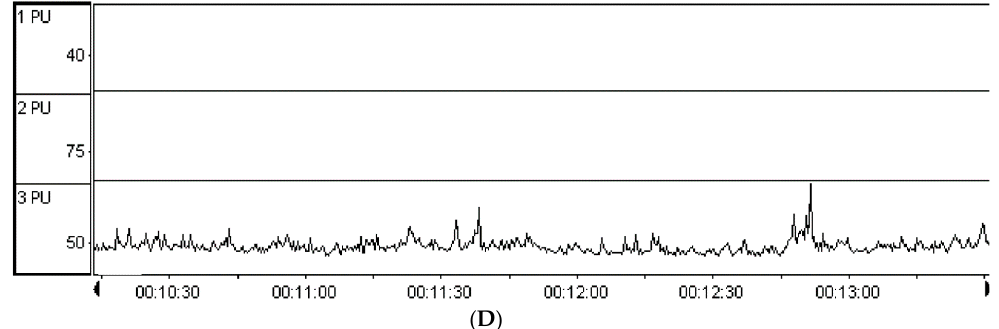
Figure 7. The diagram for blood flow (Vm) determined by means of a Transcranial Doppler (TCD) instrument. ( A ) Blank control and ( B ) VBI model in the vertebral artery; ( C ) blank control and ( D ) VBI model in the basilar artery. Table 3. Different concentrations of GGDs’ effect on blood flow data and AT 1 R mRNA/AT 2 R mRNA expression ( x ˘ sd , n =